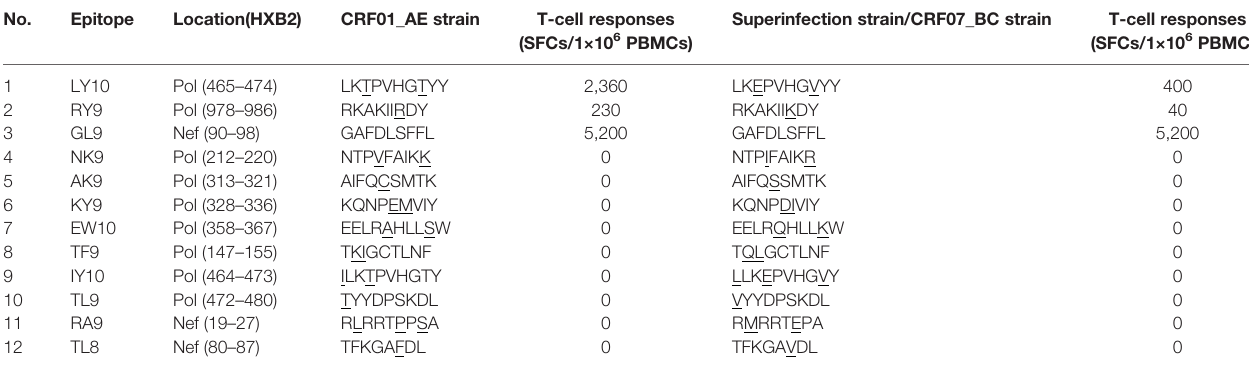
TABLE 2 | T-cell responses targeting epitopes in recombination